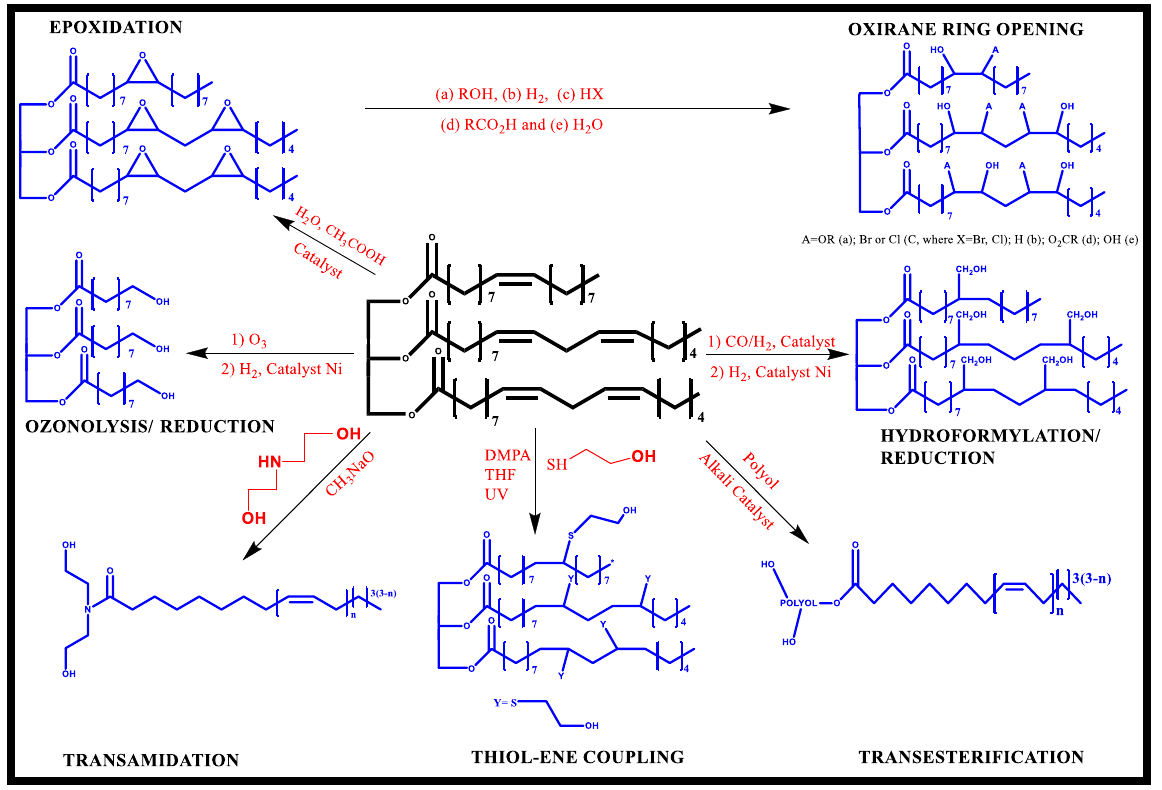
Figure 3. Synthetic pathways for the synthesis of polyols based on vegetable oil [25].